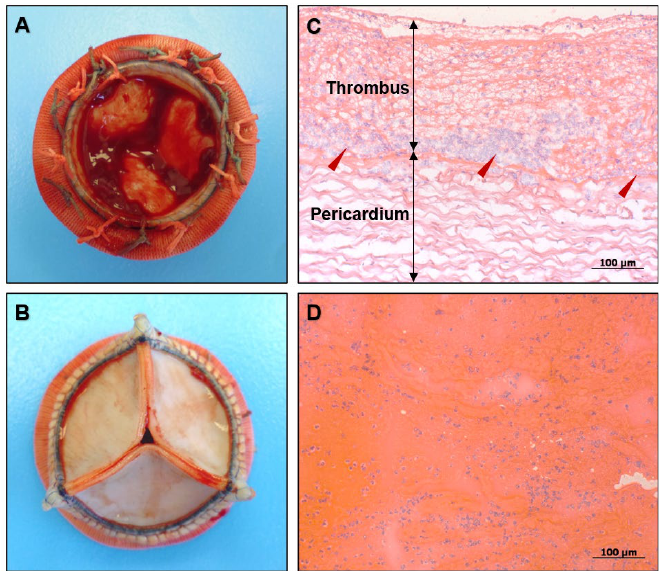
Figure 1. General examination of the excised bioprosthetic valve. ( A ) A massive thrombus located on the inflow side of the excised BHV; ( B ) Thrombosis-free outflow side of this BHV; ( C ) Polymorphonuclear leukocytes (indicated by red arrows) heavily infiltrated the thrombus (top) but did not invade the prosthetic leaflets (bottom). Hematoxylin and eosin staining, magnification ×200. Scale bar = 100 µm; ( D ) Left atrial thrombus also contained numerous polymorphonuclear leukocytes. Hematoxylin and eosin staining, magnification ×200. Scale bar = 100 µm.